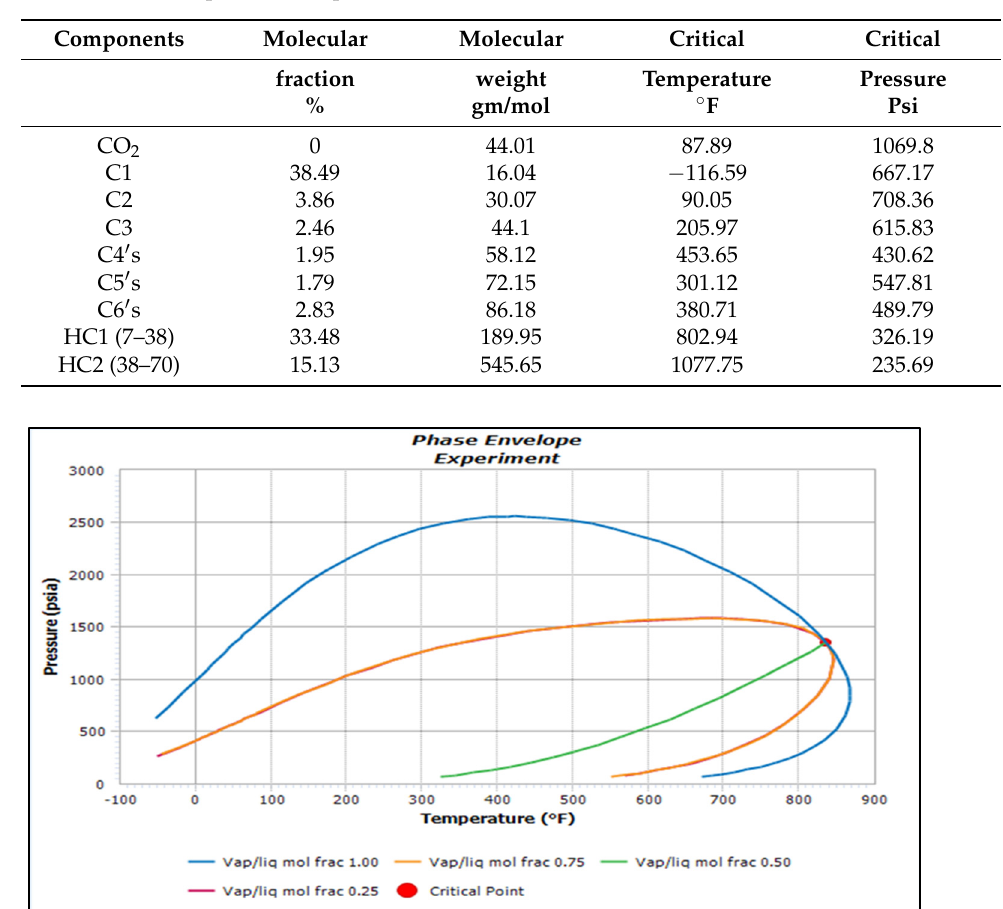
Table 1. Fluid composition sampled from the FWU.